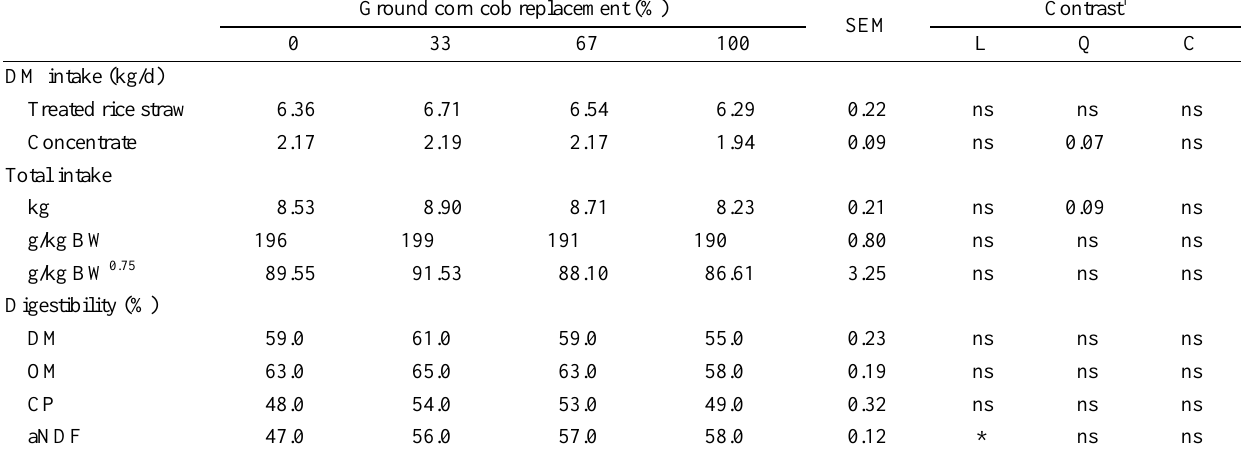
Table 2. Effect of the replacement of cassava chip by ground corn cob on total feed intake and